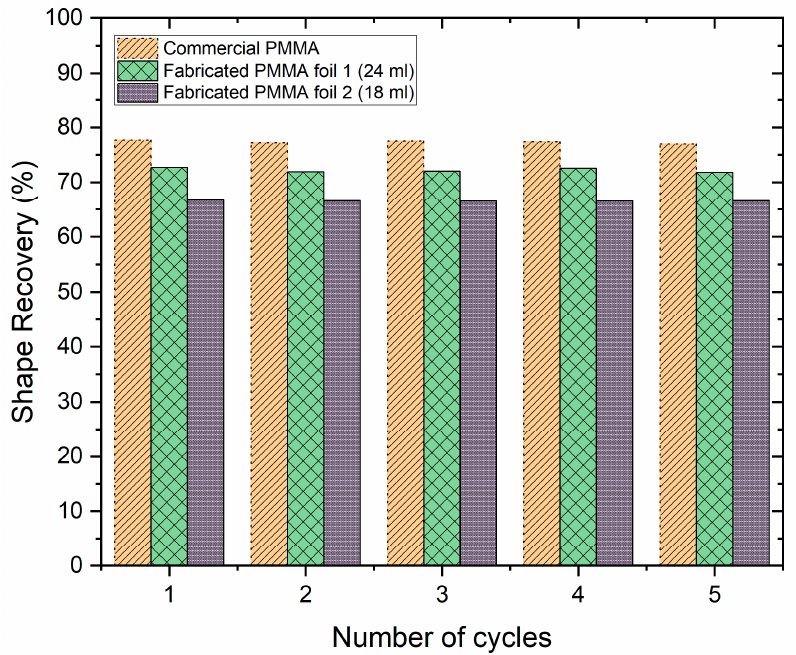
Figure 9. Shape recovery (%) for commercial PMMA, fabricated 1 and 2 as the function of number cycles.